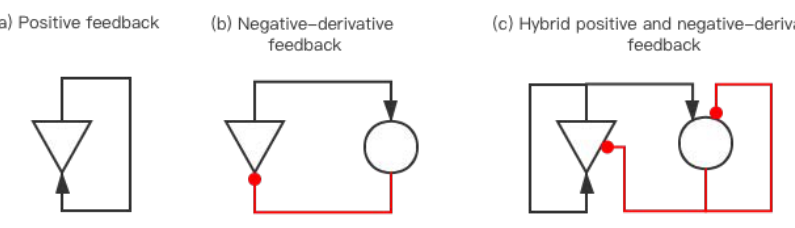
Figure 1. Comparison of different models. The solid red line is an inhibitory connection, and the solid black line is an excitatory connection. ( a ) The positive feedback model can maintain the continuous activity of neurons. ( b ) The negative-derivative feedback model can offset the drift of the neuron state to a certain extent. ( c ) Hybrid positive and negative-derivative feedback model